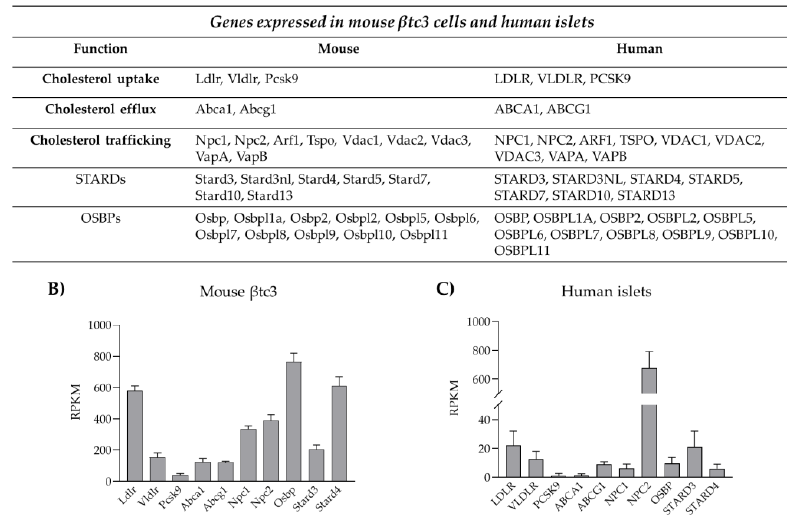
Figure 2. Machinery involved in cholesterol homeostasis and trafficking in pancreatic β -cells. ( A ) Genes involved in cholesterol uptake/efflux and lipid trafficking expressed in mouse β tc3 cell line and human isolated islets of Langerhans. ( B ) RNA-seq data of genes involved in cholesterol homeostasis and expressed in mouse β tc3 cells (unpublished data). Data are expressed as reads per kilobase of transcript per million (RPKM) and are mean ± SD (n = 5 samples). ( C ) RNA-seq of genes involved in cholesterol homeostasis and expressed in human islets of Langerhans. Data are expressed as reads per kilobase of transcript per million (RPKM) and are mean ± SD (n = 6 healthy donors of varying BMI and age). The analysis on human islets was performed using the dataset published by Segerstolpe et al., 2016 [75].